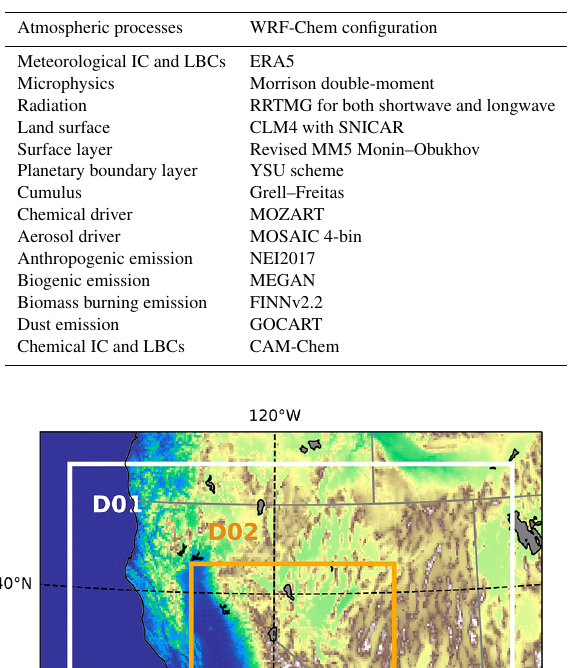
Table 1. Model configuration.